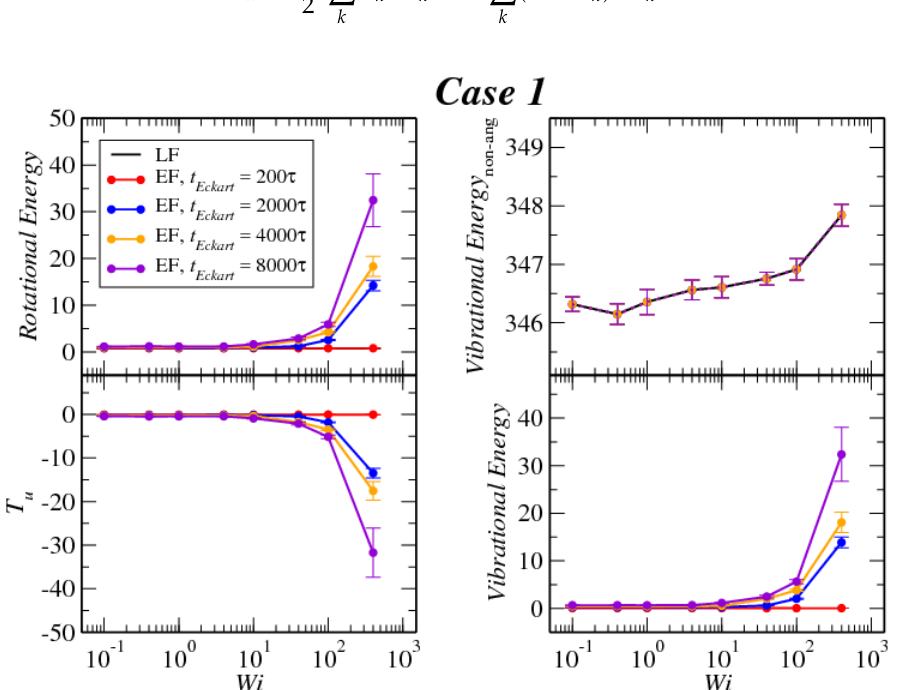
Figure 8. Comparison between the values of the kinetic energy for Case 1 evaluated in both the lab and Eckart frames at different Eckart times (Table